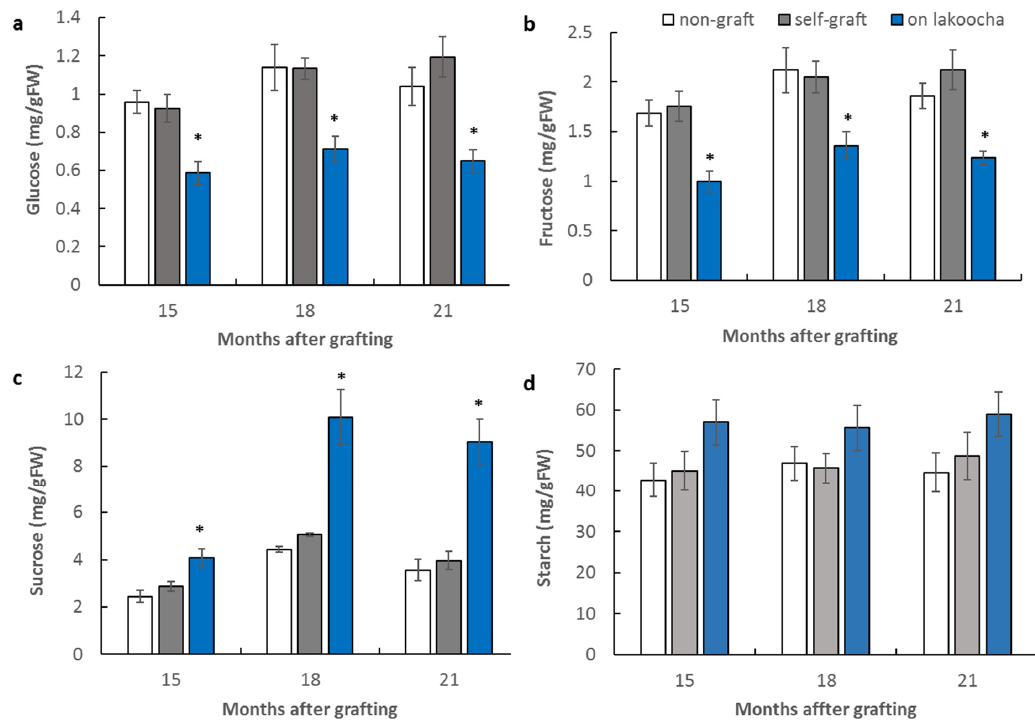
Figure 4. Non-structural carbohydrate contents in scion leaves of breadfruit plants growing on different rootstocks. ( a ) Glucose contents; ( b ) Fructose contents; ( c ) Sucrose contents; ( d ) Starch contents. All values represent mean ± SE from five biological replicates (* p < 0.05). In root tissues, significantly lower glucose and fructose levels were also detected in lakoocha rootstocks at both 18 and 21 months after grafting, with a reduction of 43.1% (18 months) and 39.7% (21 months) in glucose, and a reduction of 45.6% (18 months) and 39.2% (21 months) in fructose compared with those of self-graft at the same time (Figure 5). Lev- els of glucose and fructose in root tissues were not significantly different between the self- graft and non-graft. While there was no difference in sucrose levels between the types of rootstocks, higher starch contents were detected in roots of lakoocha rootstocks for all the time-points, all with an increase of over 50% compared with the self-graft and non-grafted. Levels of starch in root tissues were not significantly different between the self-graft and non-graft (Figure 5).